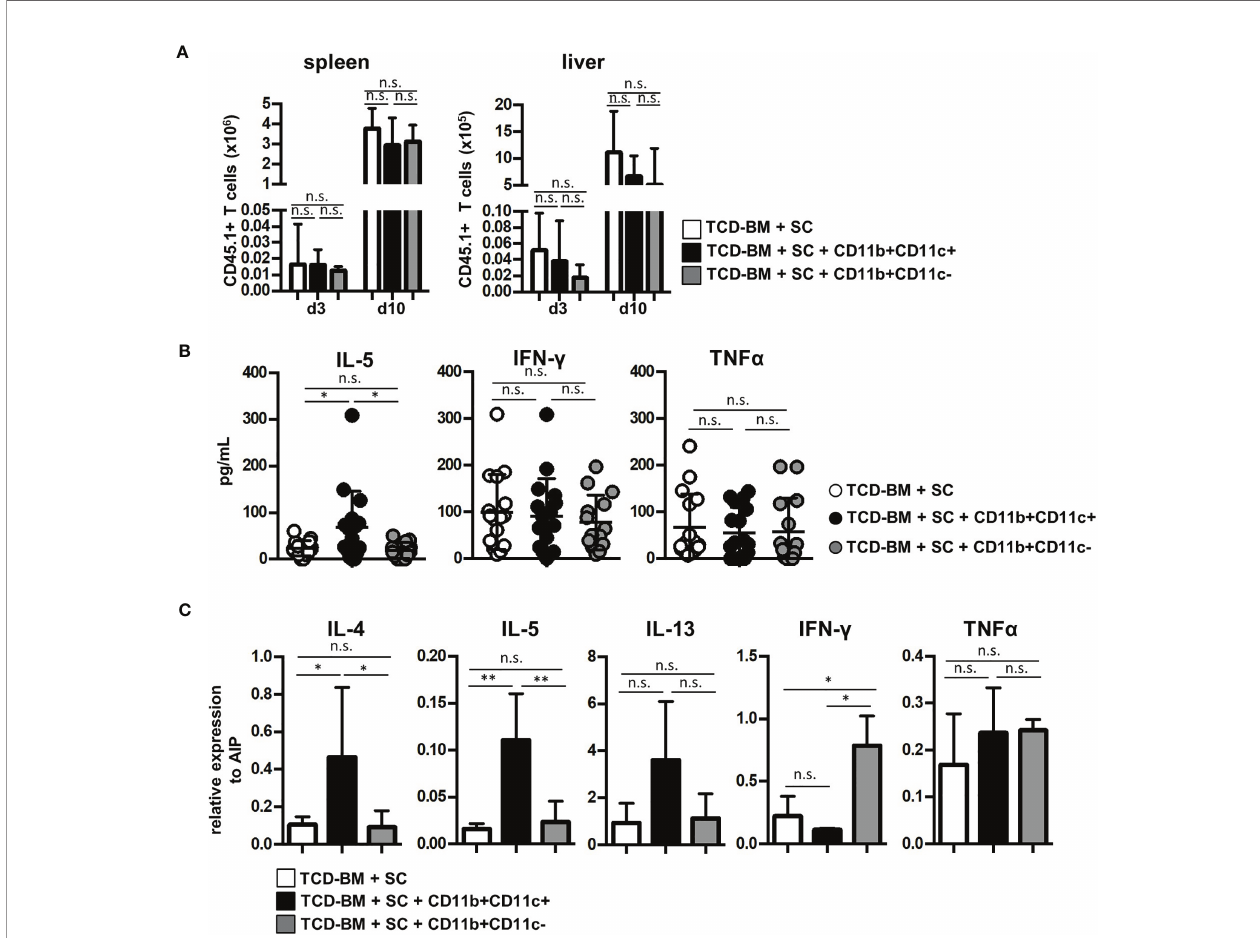
FIGURE 4 | Cotransplantation of CD11b+CD11c+ MDSCs does not prevent allogeneic T-cell expansion and homing but induces type 2 immunity. (A – C) Lethally irradiated B6.bm1 (H-2K bm1 , CD45.2) mice were reconstituted with B6-derived (H-2K b , CD45.2) TCD-BM and B6.SJL-derived (H-2K b , CD45.1) spleen cells in the presence or absence of B6-derived (H-2K b ; CD45.2) CD11b+CD11c+ or CD11b+CD11c − MDSCs. (A) Spleen and liver were analyzed for in fi ltrated allogeneic CD45.1+ T cells 3 and 10 days after transplantation. (B) Ten days after transplantation, serum cytokine concentrations of Th2- (IL-5) and Th1-associated (IFN- g and TNF- a ) cytokines were determined. (C) Ten days after transplantation, splenic T cells were isolated and relative mRNA expression of Th2- (IL-4, IL-5, IL-13) and Th1- associated (TNF- a , IFN- g ) cytokines was analyzed by qRT-PCRs. (A) Data represent the mean value ± SD of three mice/group. Kruskal-Wallis test. (B) Data represent the mean value ± SD of 14 – 16 mice/group. (C) Data represent the mean value ± SD of n = 3 – 5 samples with cells from three to fi ve pooled mice/sample. (B, C) ANOVA Tukey multiple comparison test. * p ≤ 0.05; ** p ≤ 0.01. n.s., not signi fi